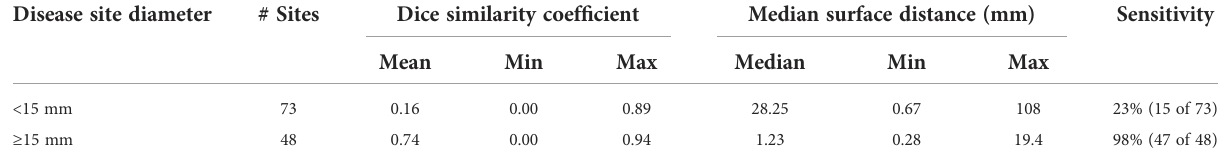
TABLE 3 Mean, min, and max Dice similarity coef fi cient and median surface distance and sensitivity for individual disease sites by differing size criteria of the 3D-IRCADb dataset. Disease site